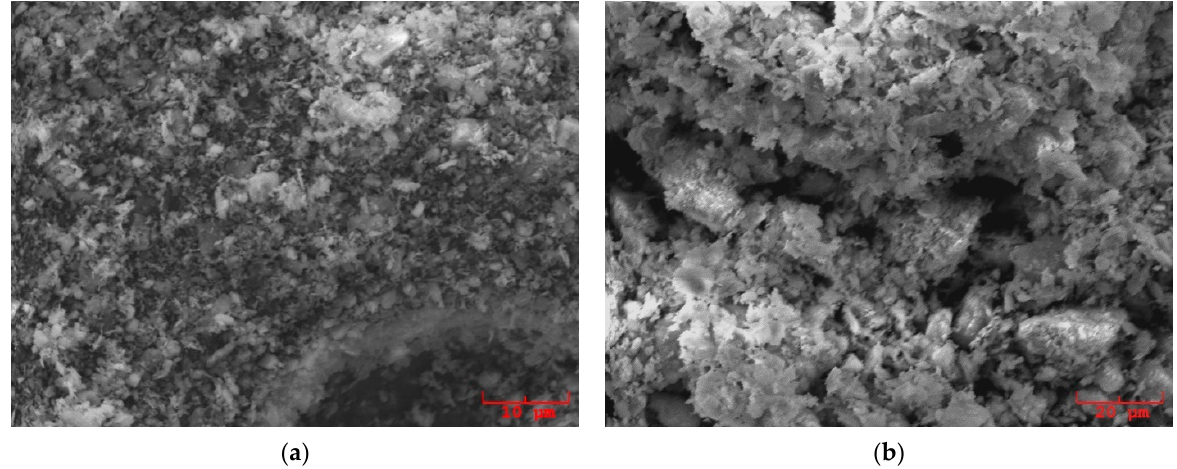
Figure 1. SEM micrographs of ( a ) Metamax and ( b ) Masterlife MK828 metakaolin powders.